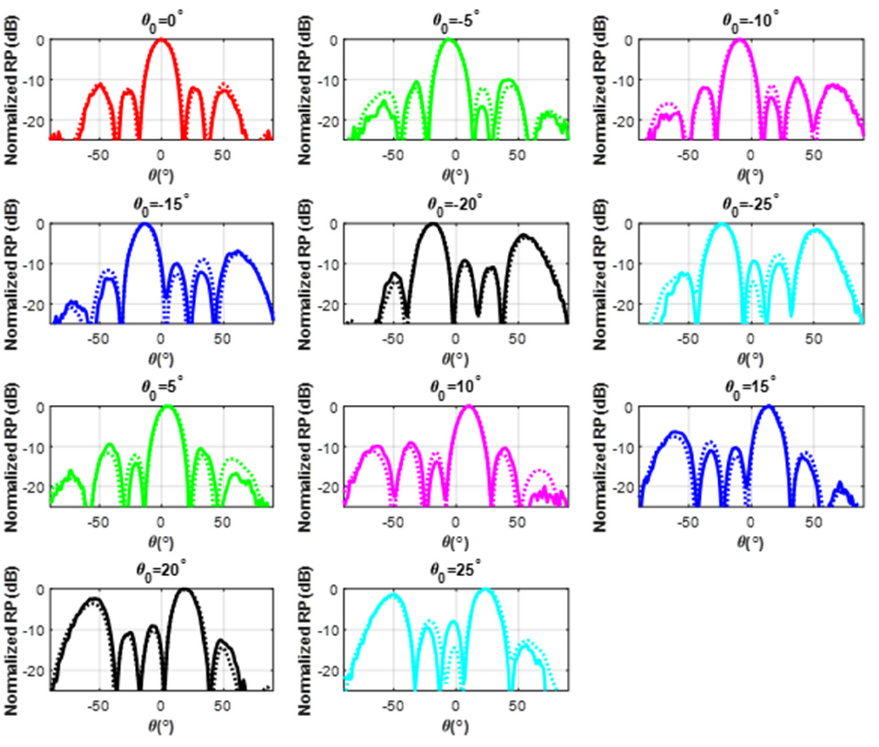
Figure 9. H-plane cut ( φ = 0) of the radiation pattern produced by the waveguide array for different scanning directions θ 0 . The solid line corresponds to the measurements and the dotted line corresponds to the simulations.